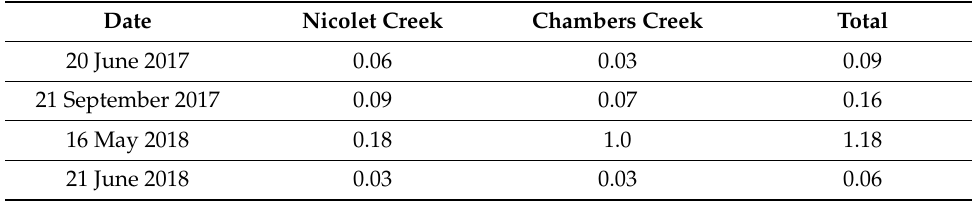
Table 2. Field measurements of discharge (m 3 /s) for Nicolet and Chamber Creeks.